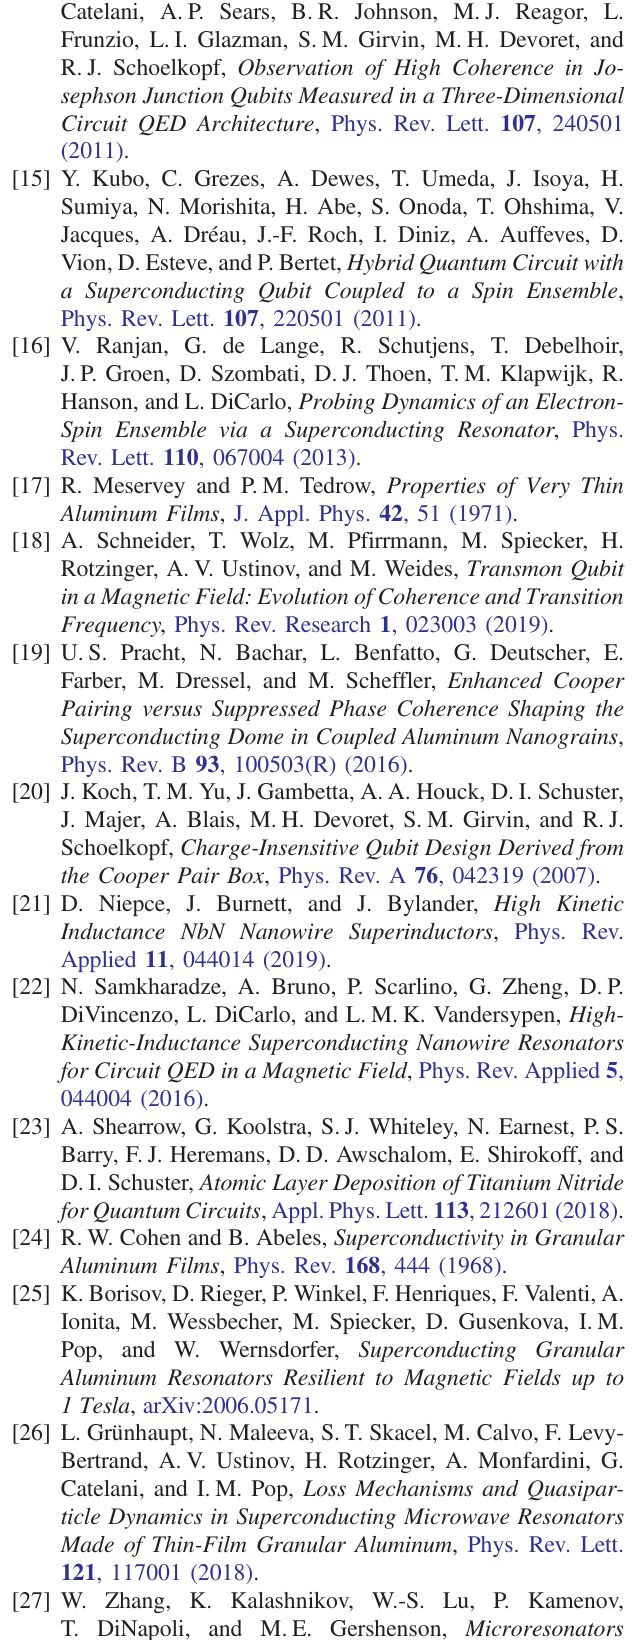
section along the short (black) and the long (gray) edge of the grAl volume. The AFM measurement confirms the grAl film thickness of t ¼ 10 grAl